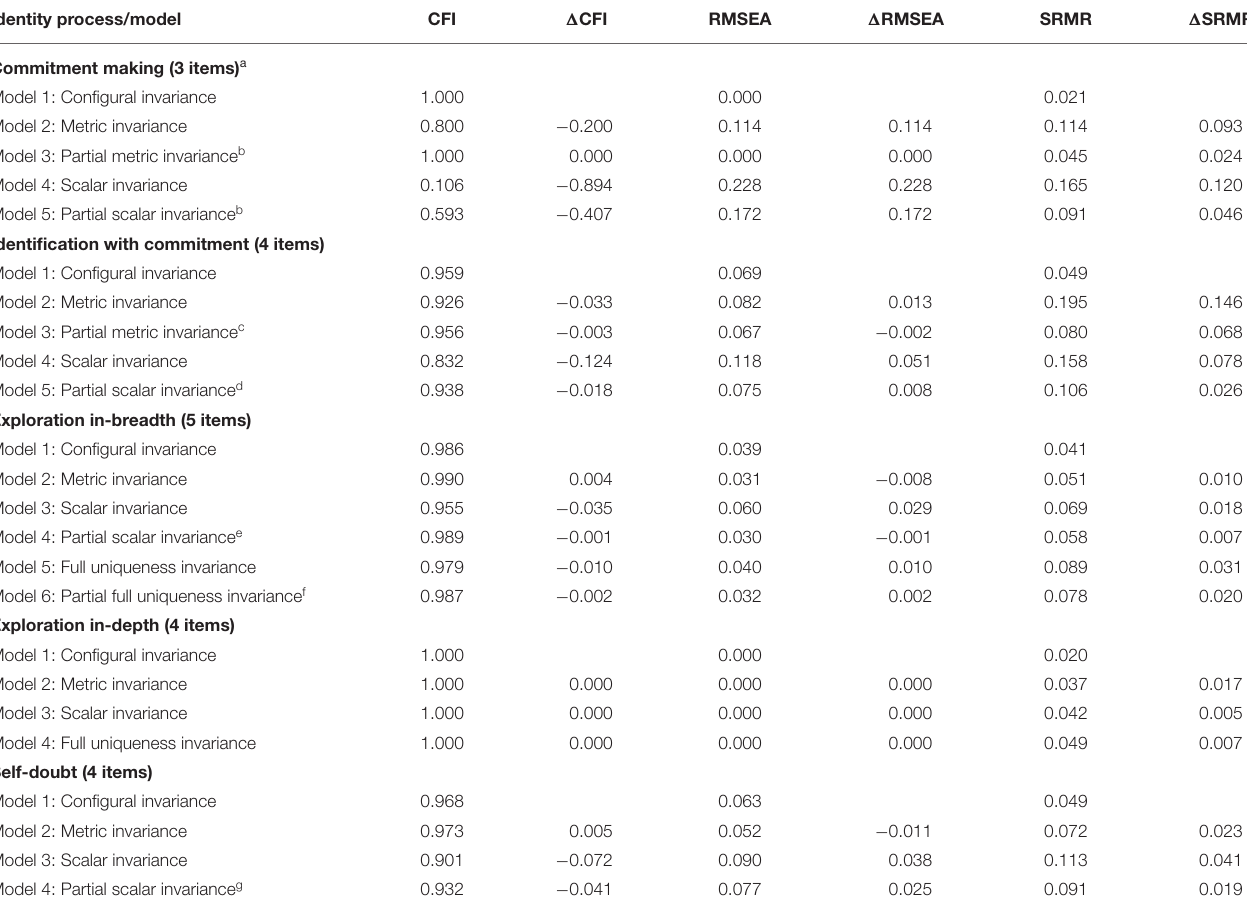
TABLE 3 | Model fit for the different levels of pre-transition measurement invariance over